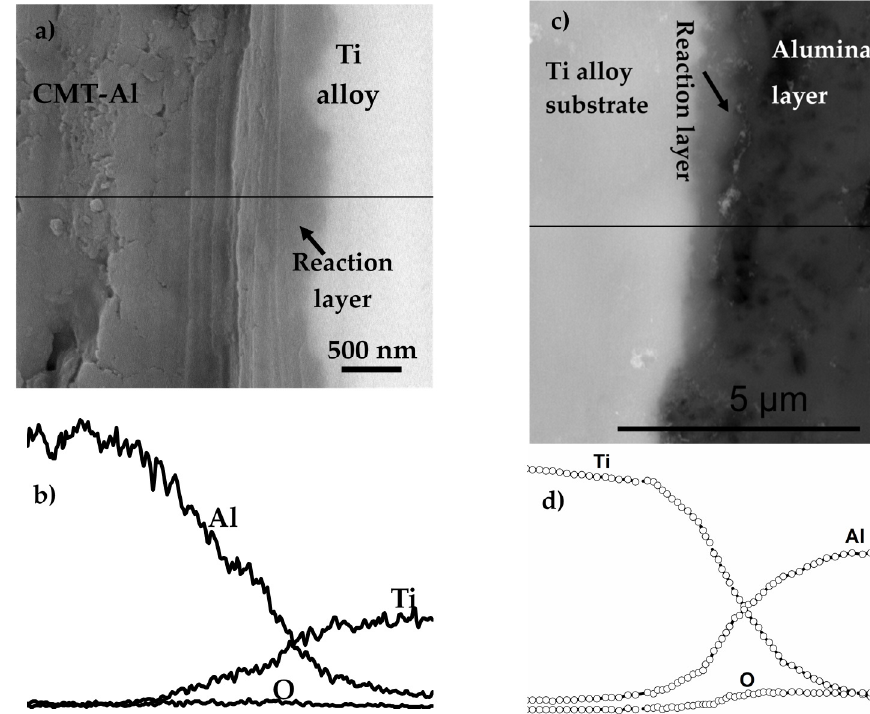
Figure 11. BSE image and line profile of cross-section of CMT-Al: Before MAO treatment ( a , b ); and after MAO treatment ( c , d ). Reproduced from [103] with permission from Cambridge Core.